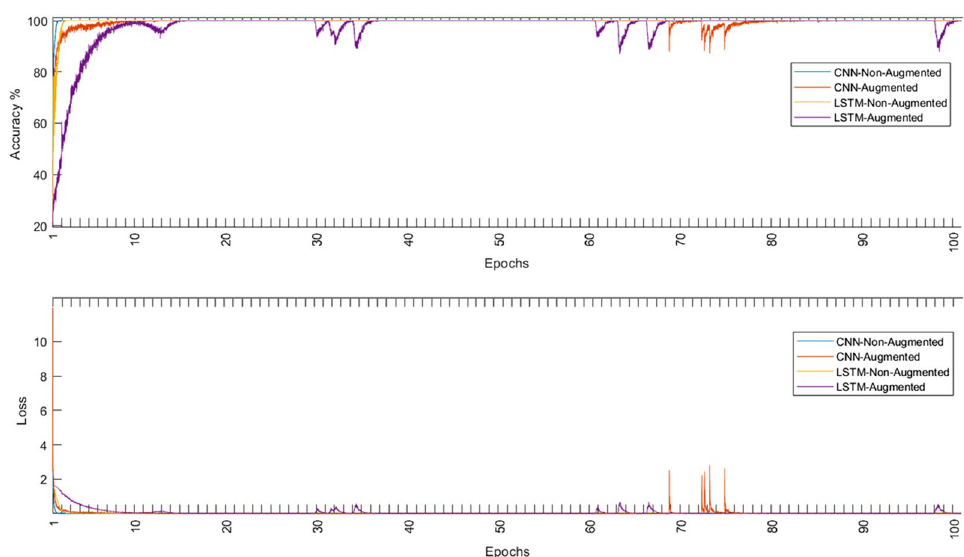
Figure 8. The average training accuracy and loss curves of different folds for all models in the ablation